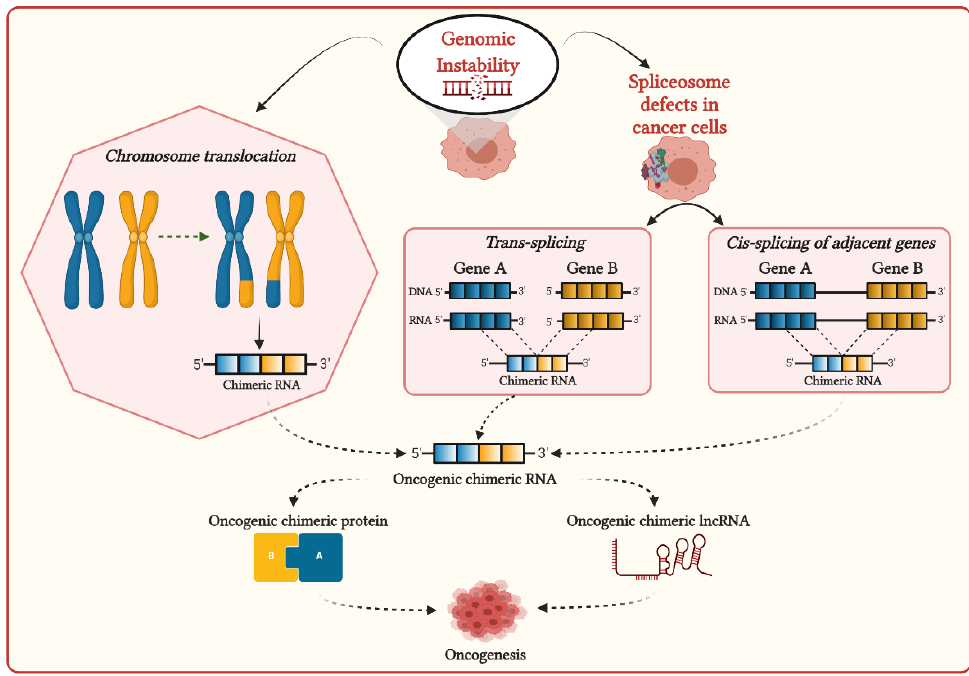
Figure 1. Possible mechanisms for the generation of chimeric transcripts in cancer cells.